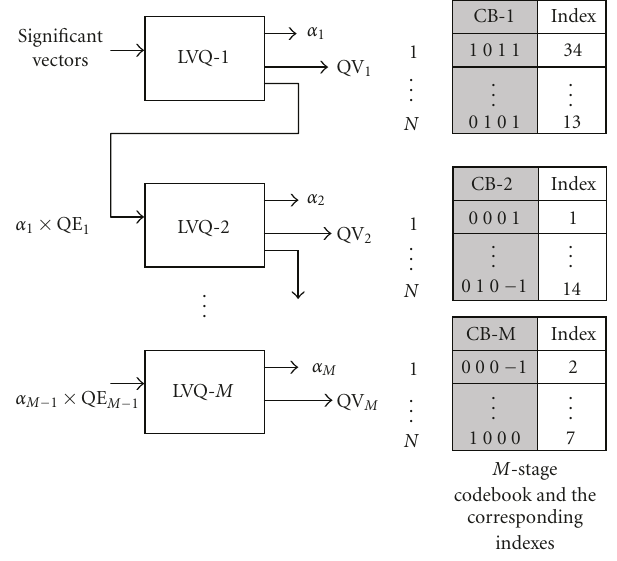
Figure 4: MLVQ process of a particular subband.